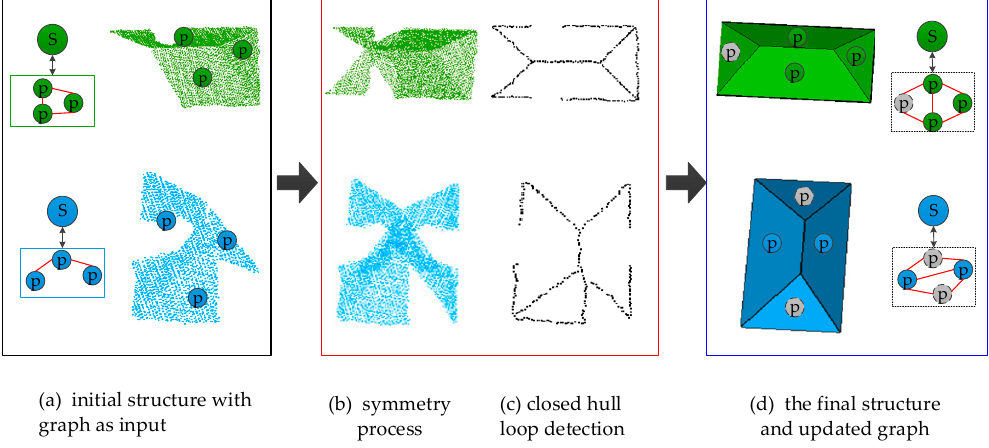
Figure 10. A process of model refinement. ( a ) Initial grouped structures and the corresponding sub-graph of RAG; ( b ) symmetry enhancement with structural knowledge; ( c ) closed hull loop detection by the projected primitives; and ( d ) the final refined structures and updated graph.